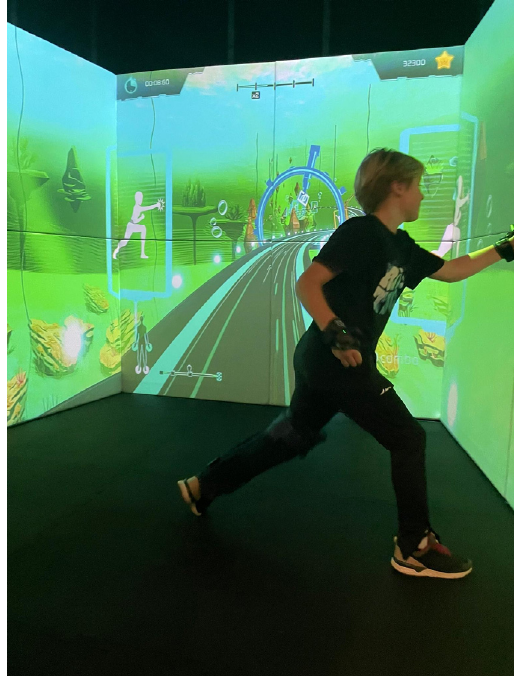
Figure 1. Student playing “Sphery Racer” in the ExerCube by Sphery Ltd. (Au, Switzerland) © Anna Lisa Martin-Niedecken.